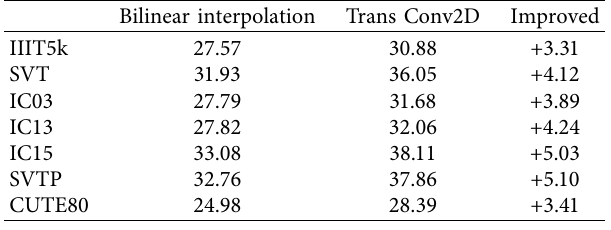
Table 3: PSNR results of restored images by Trans Conv2D and bilinear interpolation (dB).